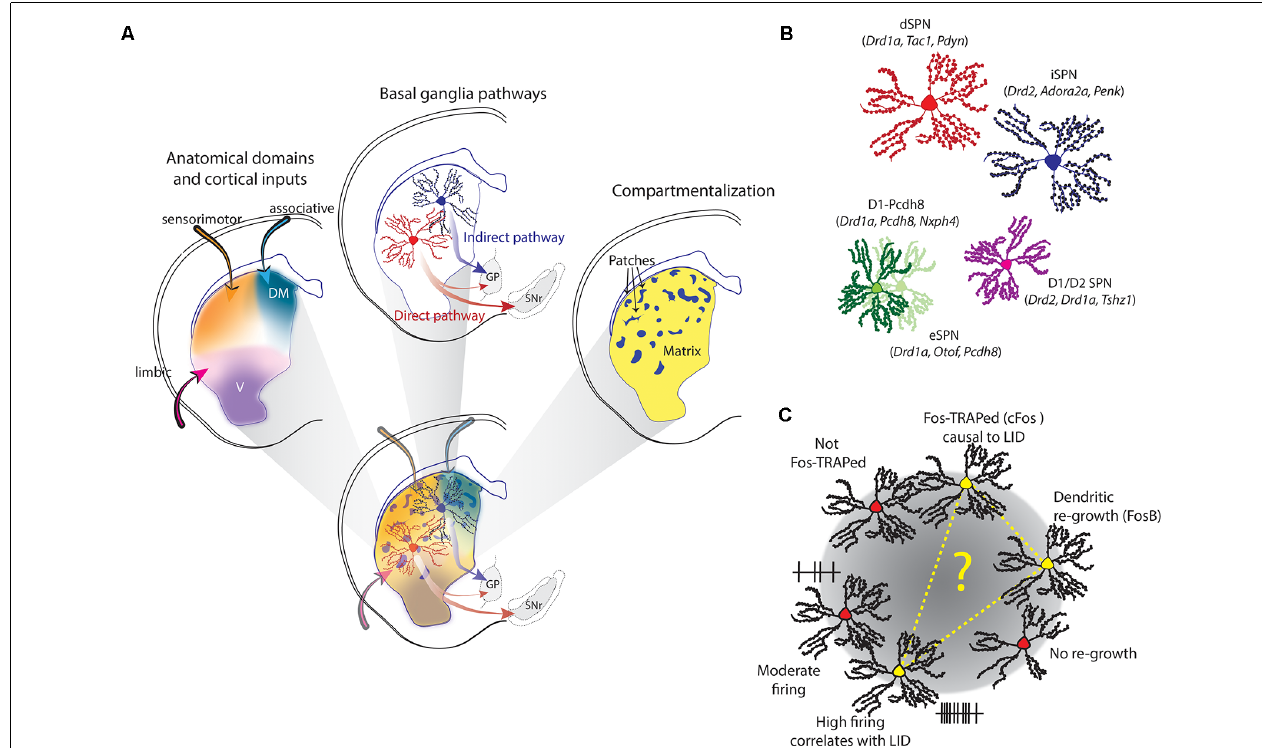
FIGURE 1 | Striatal heterogeneity, spiny projection neuron (SPN) (sub-) populations and L-DOPA-induced dyskinesia (LID)-associated dSPNs. (A) The rodent striatum constitutes a complex, overlapping field of heterogeneity. It combines anatomic-functional domains, patch/matrix compartmentalization, and the “classical” distinction of dSPNs and iSPNs, which anchor the direct and indirect pathway of the basal ganglia. (B) Apart from “classical” SPNs, also D1/D2-SPNs were described in scRNA-seq studies, as well as new sub-populations. Characteristic genes are given in parentheses. (C) Three different studies identified a sub-group of dSPNs specifically linked to LID. The sub-group was either identified by Fos-TRAP, high-firing activity that correlates with LID, or a specific cellular phenotype. It is tempting to speculate that these three markers identified the same LID-linked subgroup of